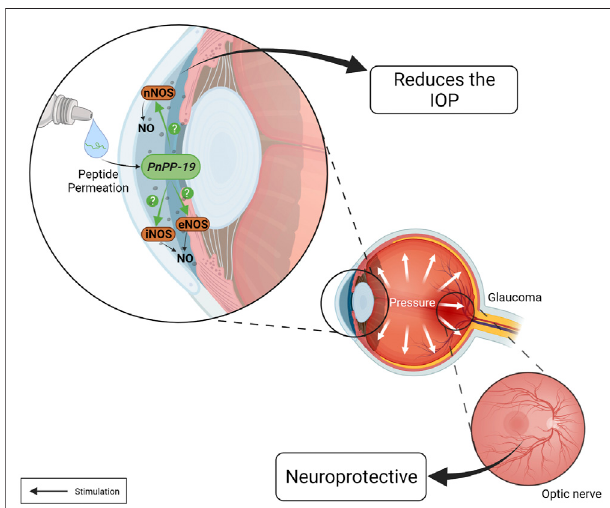
FIGURE 4 | Actions of the PnPP-19 peptide in the eye. PnPP-19 a NO- inducer peptide, when topically applied as eye drops, reduces IOP after a single instillation, both in healthy and hypertensive eyes, without eliciting apparent toxicity. However, it is unknown which NOS is activated by PnPP-19. This peptide may promote neuroprotection by preventing the progression of optic nerve degeneration. Created with